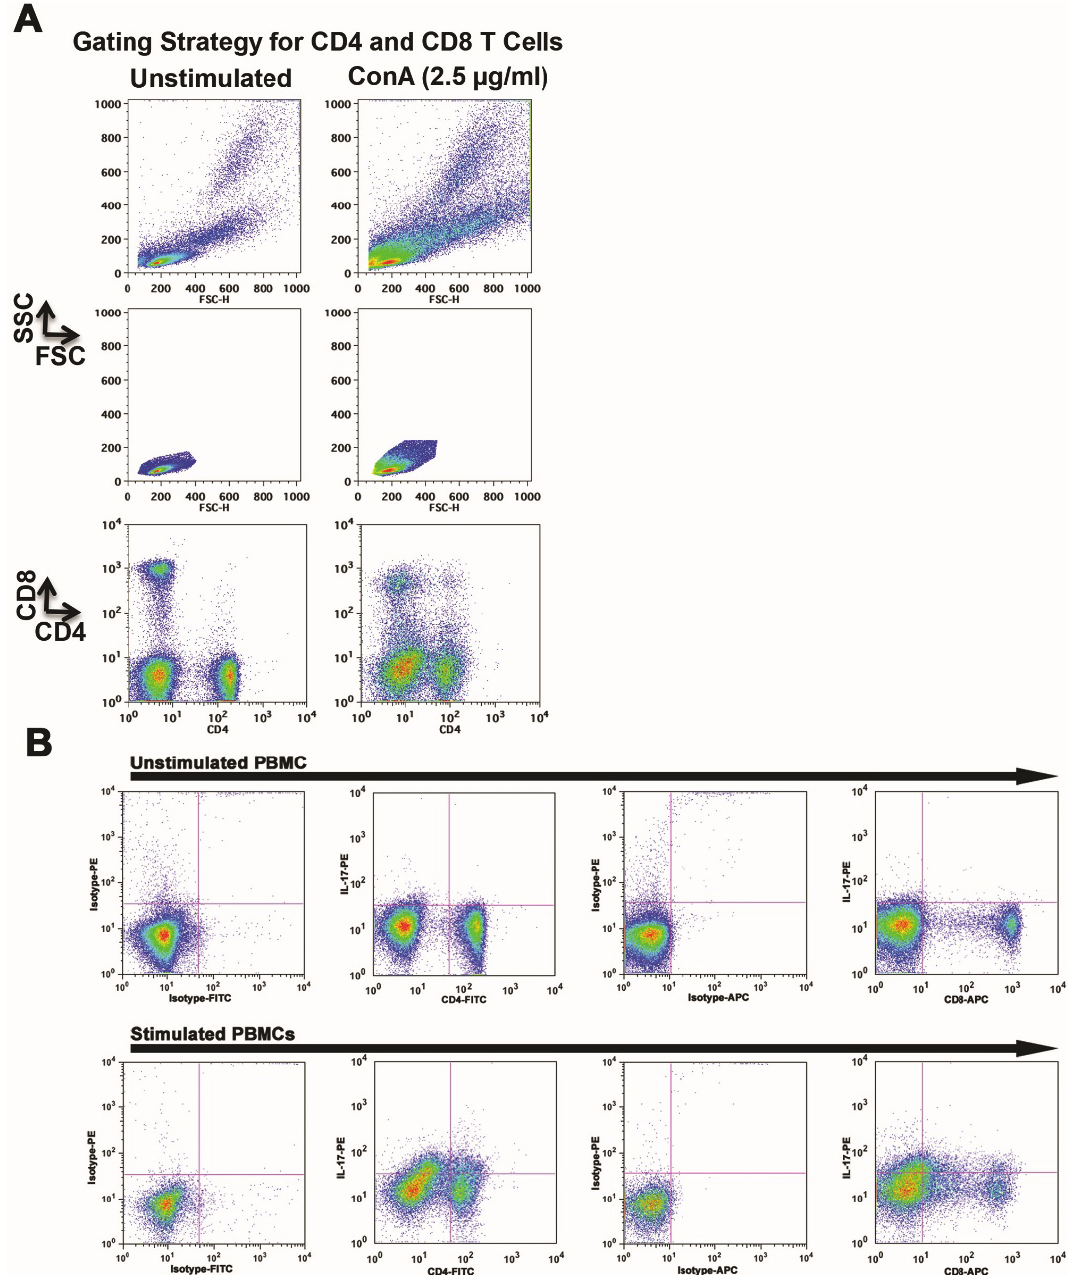
Figure 1. Stimulation of canine peripheral T cells promotes IL-17 production. ( A ) Peripheral T cells were gated from unstimulated (left) or ConA-stimulated (right) PBMCs using light scatter properties to define lymphocyte regions. The top panel shows ungated PBMCs and the middle panel shows the lymphocyte population after the white blood cell population gates were defined. The bottom panel shows separation of CD4 + and CD8 + cells based on immunostaining. ( B ) IL-17 expression was determined by intracellular staining and flow cytometry in the CD4 + and CD8 + subsets from a . Two-dimensional dot plots show staining with isotype control antibodies, as well as staining of CD4 and CD8 cells with anti-IL-17 antibody in unstimulated (top) and ConA-stimulated (bottom) cells. These results represent Dog 1 shown in Table 1. All dogs tested showed expression of IL-17 in at least one T cell subset (see Table